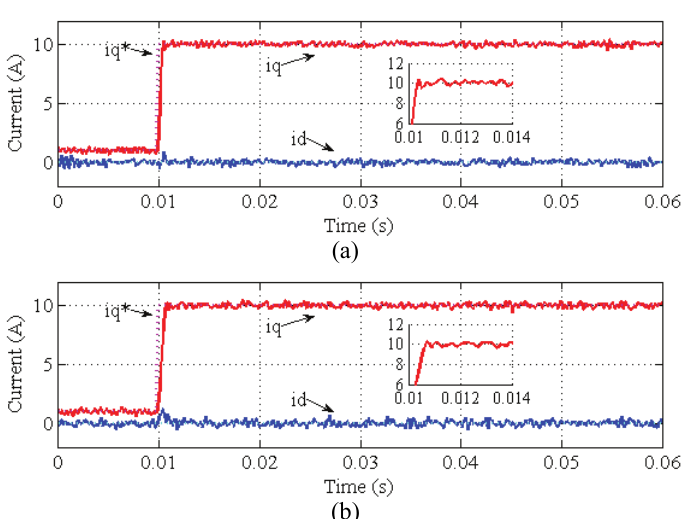
Fig. 14. dq -Axes stator currents dynamic performance of the model-based method: (a) At 100rpm; (b) At 400rpm.